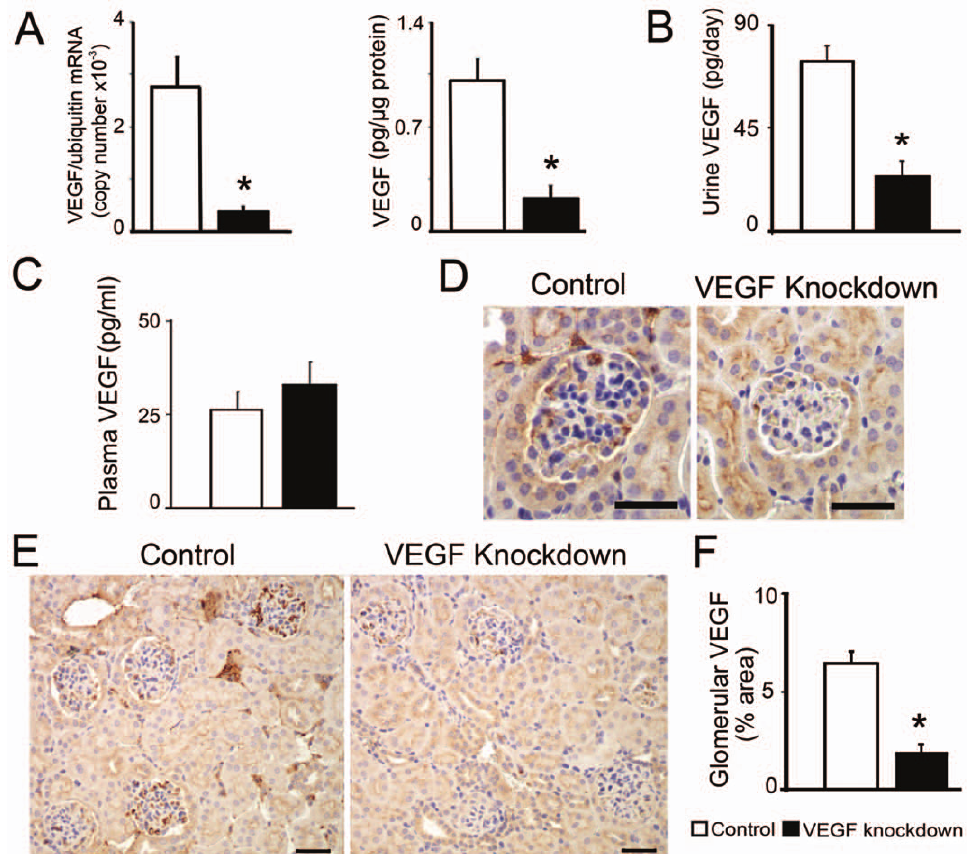
Figure 1. VEGF knockdown mouse model. (A) One week after doxycycline-induction, podocin-rtTA:tet-O-siVEGF adult mice decrease VEGF-A mRNA and VEGF-A protein levels to , 20% of controls in isolated glomeruli. (B) Urine VEGF-A decreases in VEGF knockdown mice to , 30% of control values. (C) Plasma VEGF-A is similar in VEGF knockdown and control mice. (D) VEGF immunohistochemistry shows normal expression in control (left), and decreased glomerular VEGF-A expression in VEGF knockdown mice (right), scale bar=30 m m. (E) Low magnification VEGF immunohistochemistry shows absence of VEGF in some glomeruli in VEGF knockdown mice (right), (scale bar=40 m m). (F) Glomerular VEGF-A (VEGF + area/glomerular area x100) in VEGF knockdown mice (n=135) decreases to , 30% of controls (n=118). In all bar graphs * indicates P , 0.05 compared to control.